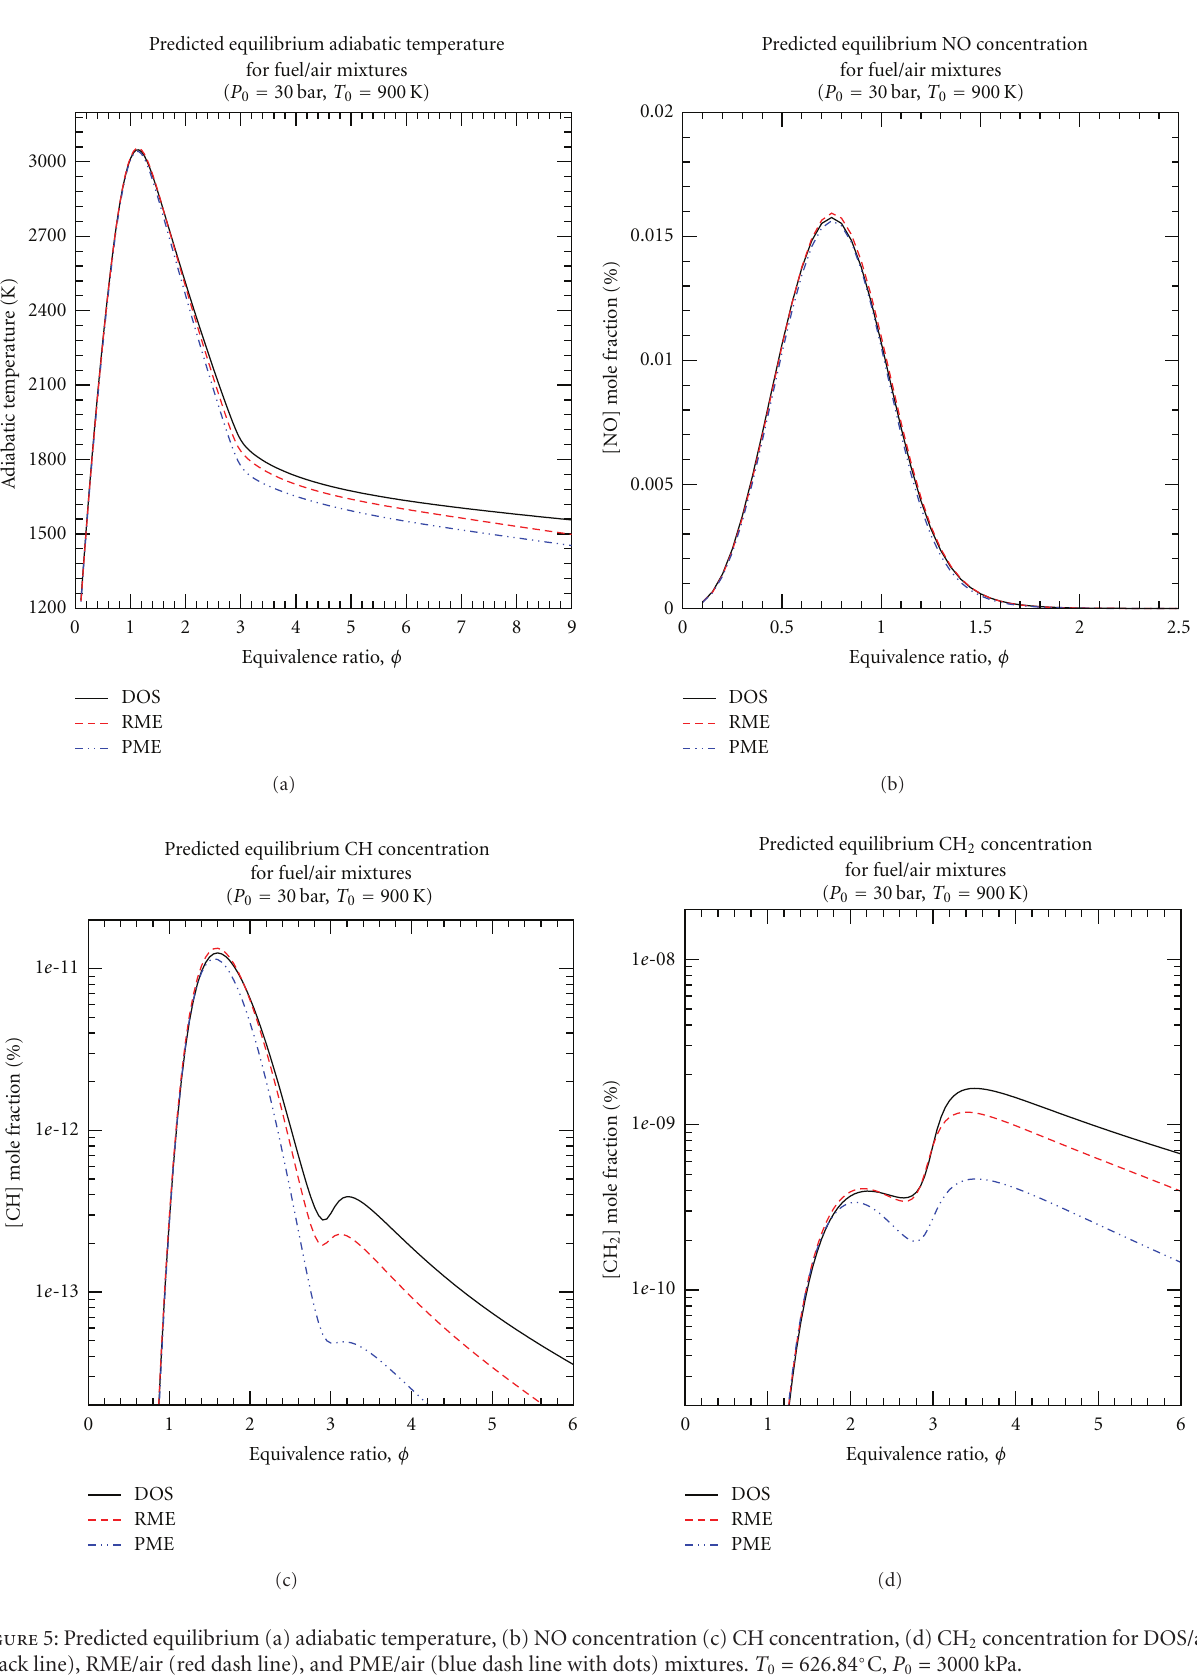
Figure 5: Predicted equilibrium (a) adiabatic temperature, (b) NO concentration (c) CH concentration, (d) CH 2 concentration for DOS/air (black line), RME/air (red dash line), and PME/air (blue dash line with dots) mixtures. T 0 = 626.84 ◦ C, P 0 = 3000